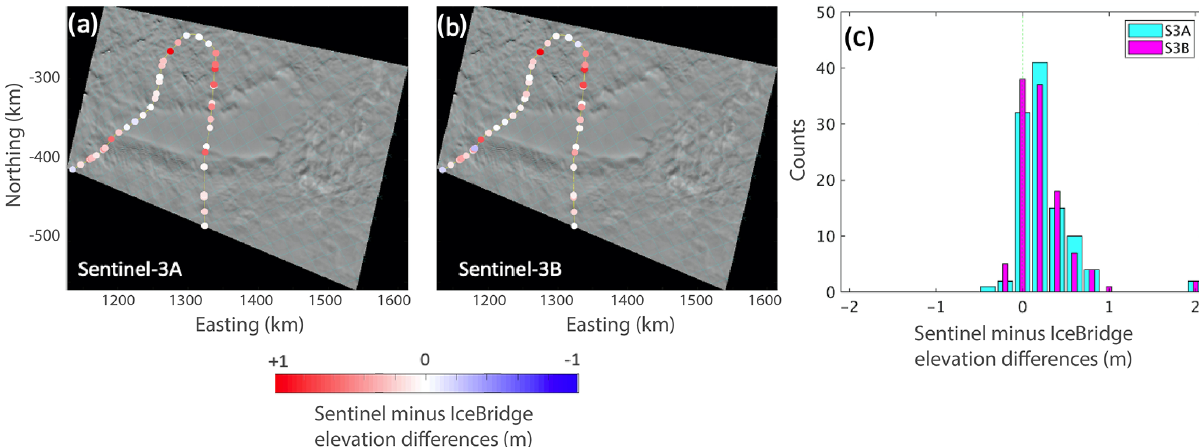
Figure 3. Inter-comparison of Sentinel-3A and Sentinel-3B accuracy at the Lake Vostok Validation site. (a) Sentinel-3A minus IceBridge elevation differences, (b) Sentinel-3B minus IceBridge elevation differences, (c) the distributions of Sentinel-3A and Sentinel-3B minus IceBridge elevation differences. Results shown are for the TCOG retracking solution provided within the ESA Level-2 product, and for acquisitions made during cycle 34 (S3A) and cycle 11 (S3B) within the tandem phase. The background image in panels (a) and (b) is taken from the MODIS Mosaic of Antarctica (Haran et al., 2006). In panels (a) and (b) , the geographical coordinates refer to a WGS84 Antarctic Polar Stereographic projection with a central meridian of 0 ◦ and a standard parallel of 71 ◦